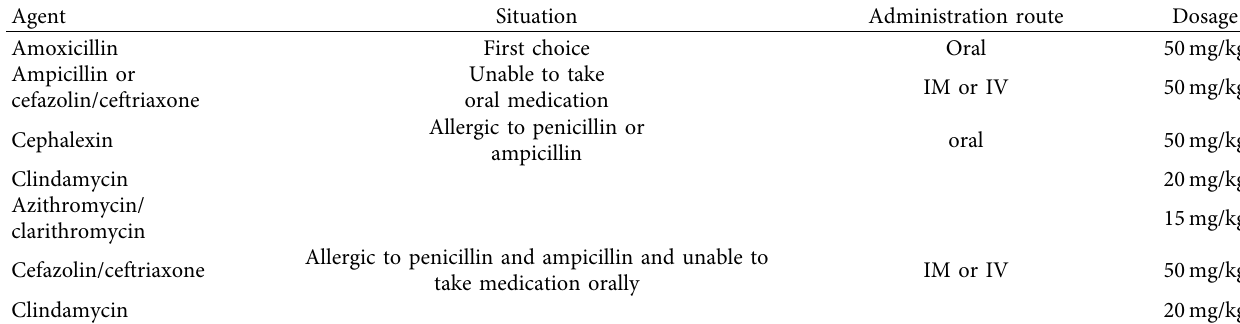
Table 3: Antibiotic prophylaxis regimen for children.